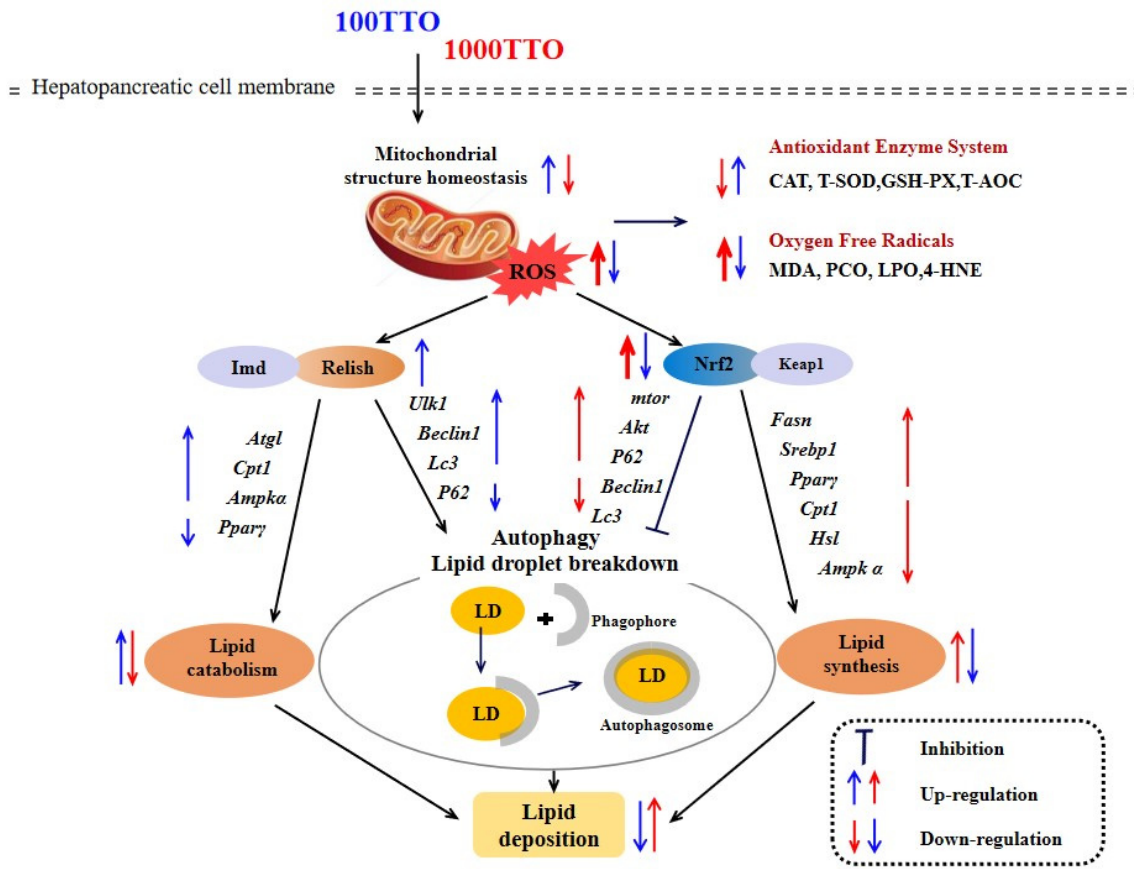
Figure 9. The mechanism of 100TTO and 1000TTO regulates lipid metabolism based on antioxidant factors Relish and Nrf2 ‐ autophagy axis. The blue arrows indicate the regulation effects of 100TTO; the red arrows indicate the regulation effects of 1000TTO. Arrows up indicate significant up ‐ regu ‐ lation or improvement, and arrows down indicate significant down ‐ regulation or inhibition. Thick arrows indicate extremely significant regulation.